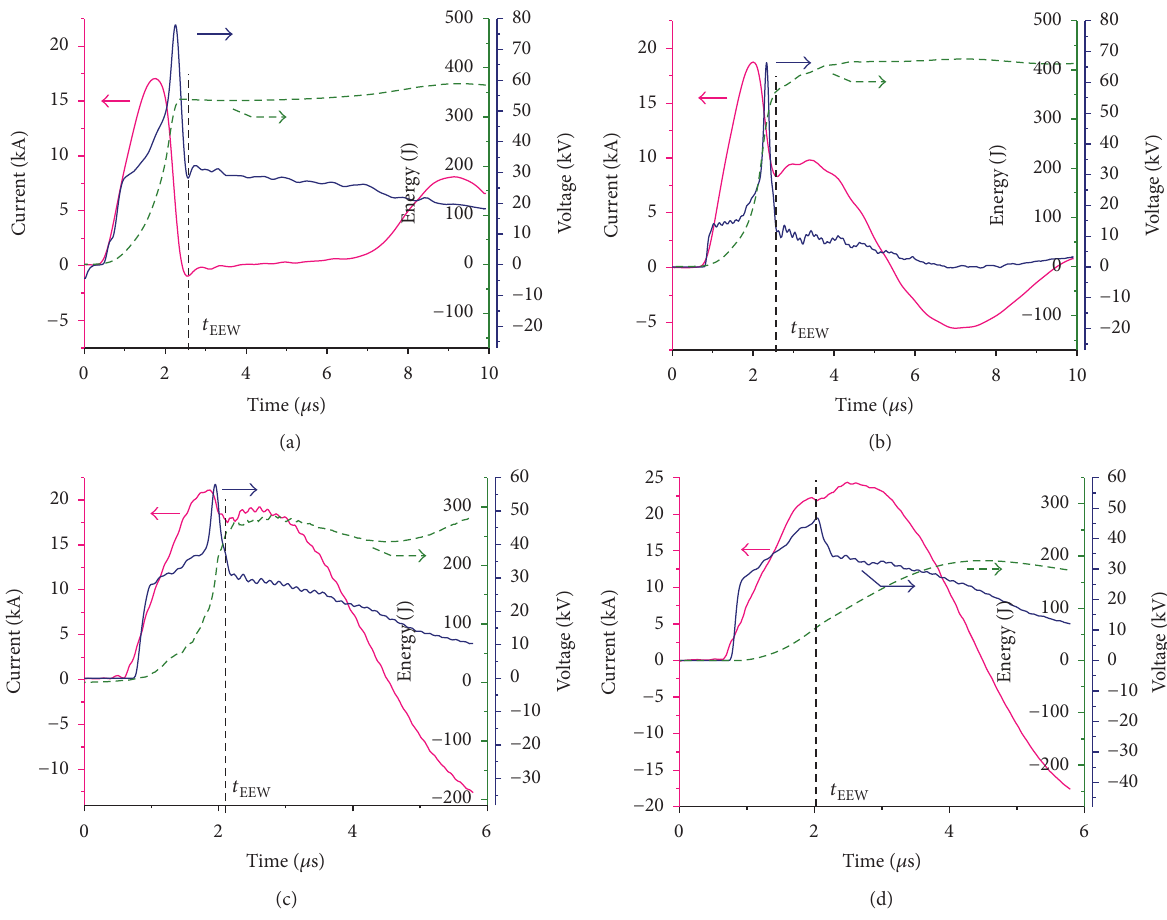
Figure 1: The EEW current and voltage waveforms: 𝑈 0 = 30 kV. ( 1 ) 𝑙 = 175 mm, 𝑒/𝑒 𝑆 = 1.1 , and 𝑒 arc /𝑒 𝑆 = 0.2 ; (b) 𝑙 = 135 mm, 𝑒/𝑒 𝑆 = 1.6 , and 𝑒 arc /𝑒 𝑆 = 0.4 ; (c) 𝑙 = 85 mm, 𝑒/𝑒 𝑆 = 2.0 , and 𝑒 arc /𝑒 𝑆 = 1.2 ; (d) 𝑙 = 60 mm, 𝑒/𝑒 𝑆 = 1.7 , and 𝑒 arc /𝑒 𝑆 = 2.8